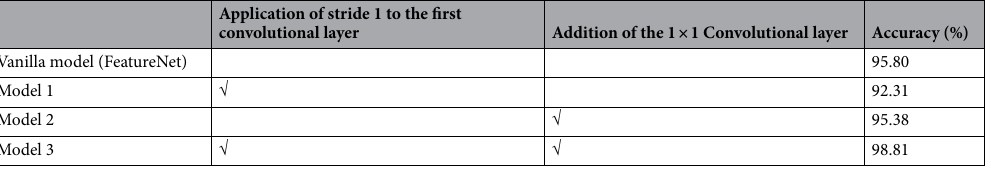
Table 7. Ablation study on the proposed network.